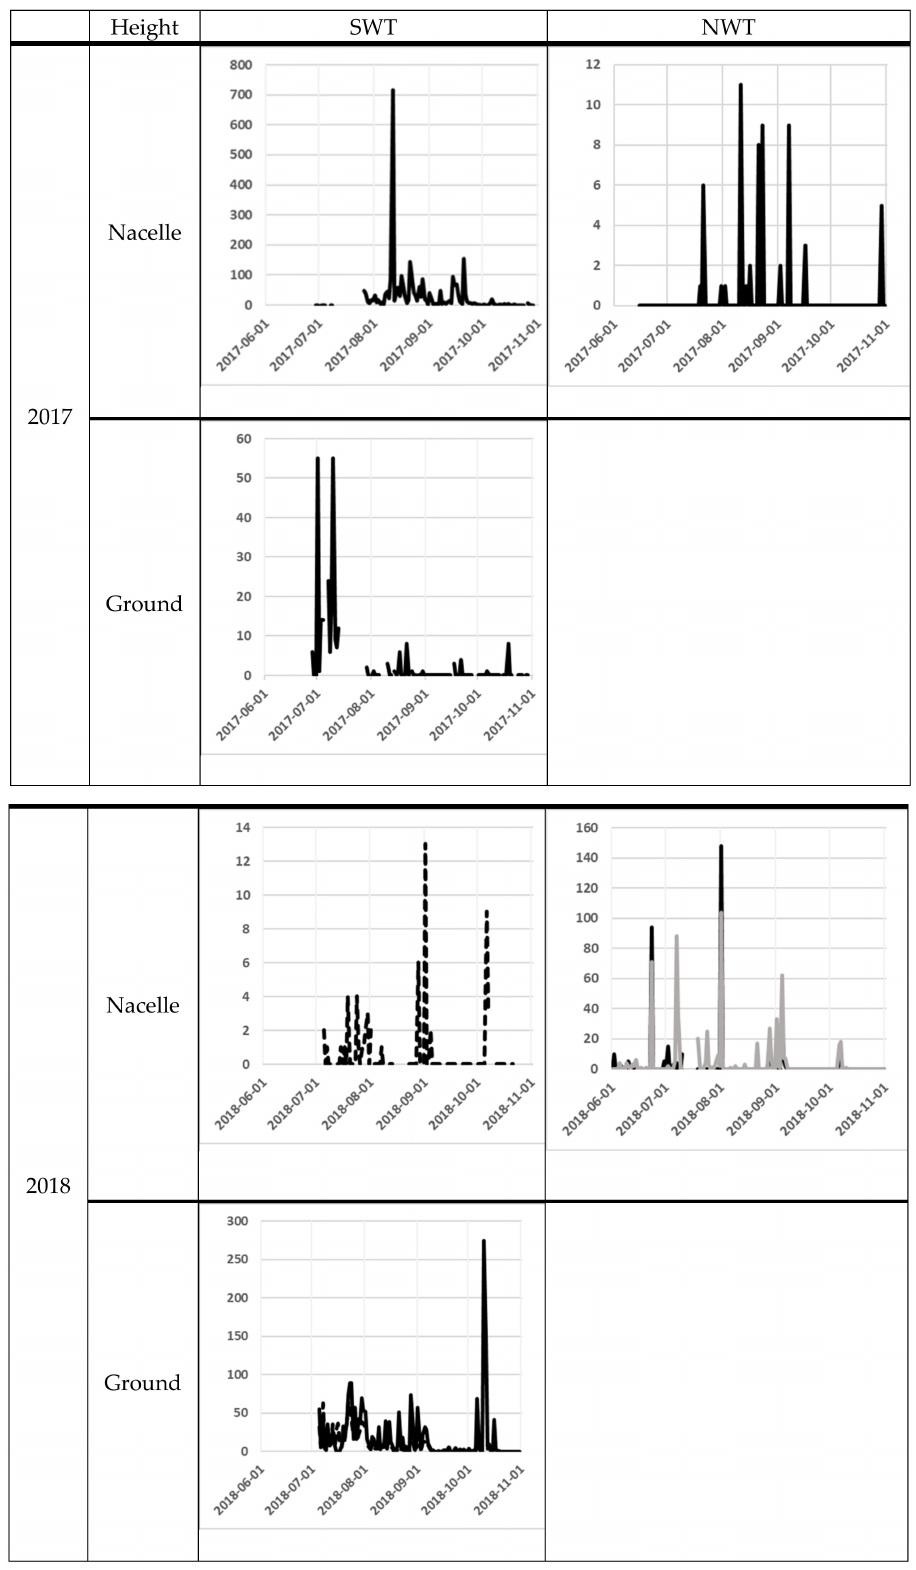
Figure 3. Bat activity per night ( y -axis) for each night ( x -axis). The filled line are for the Avisoft data and the dotted line for the D500X data. For the NWT site, the black line is for the NWT 1 and the grey line is for the NWT 2. The scale on the y -axis differs between the diagrams, because of the high variation in bat registrations between